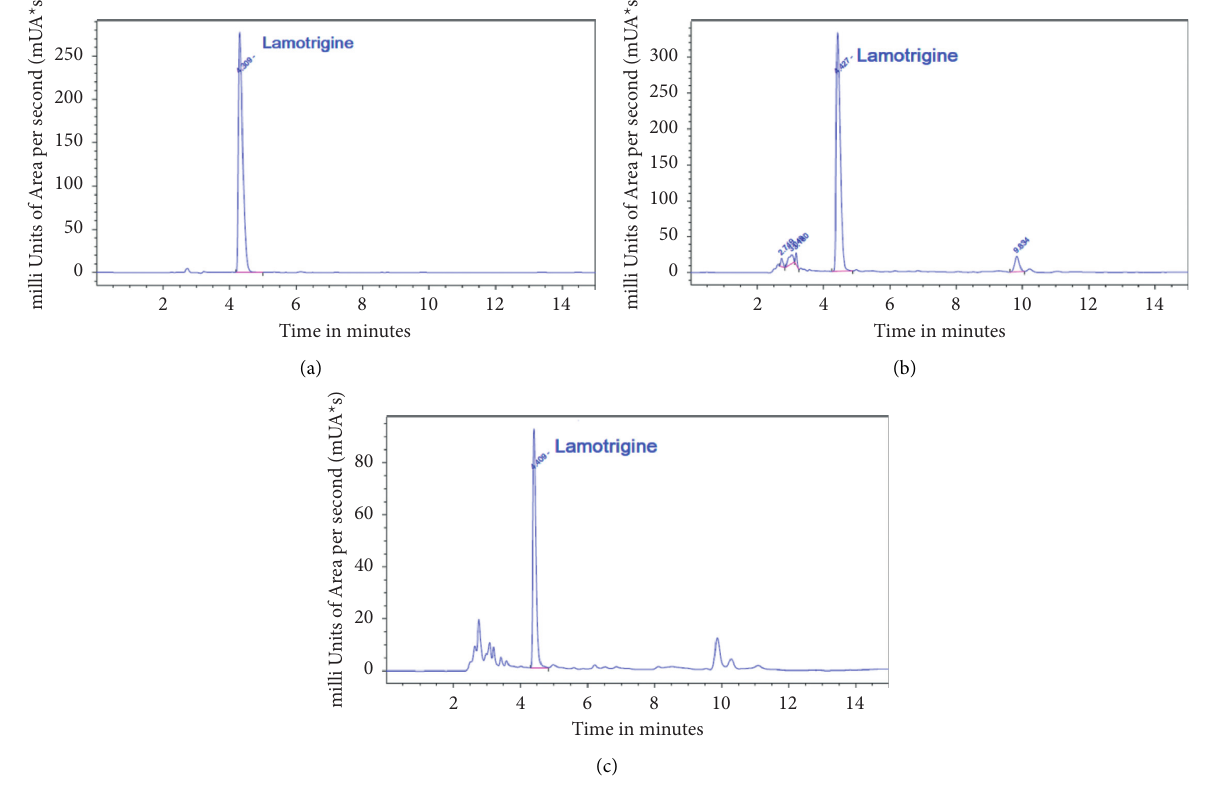
Figure 1: Chromatograms of lamotrigine in diluent (a), plasma extract loaded with lamotrigine (b), and plasma extract from a patient with bipolar disorder treated with lamotrigine